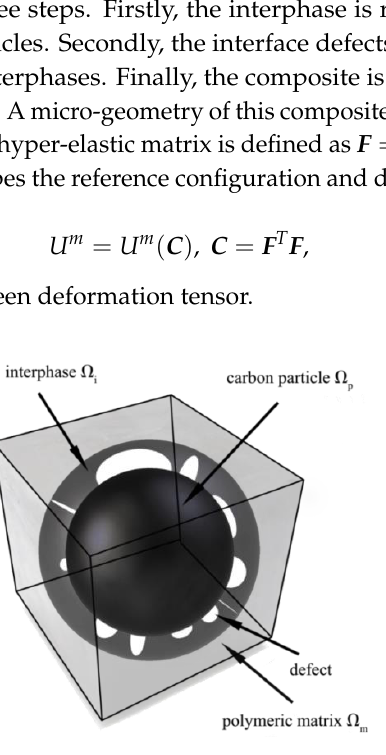
Figure 2. Micro-structure composition of the composite under consideration.